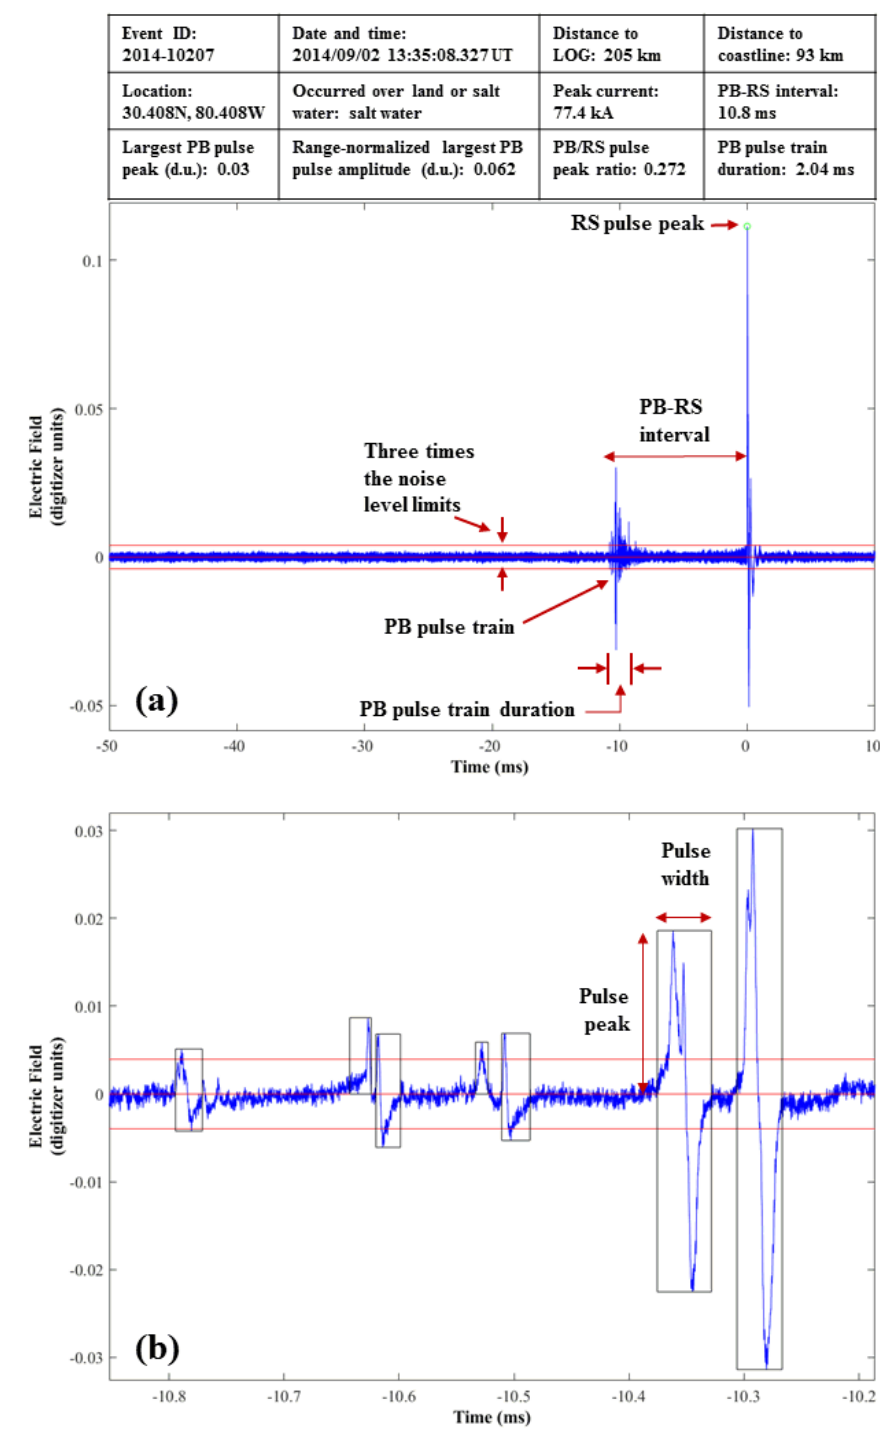
Figure 2. ( a ) An example of the output figure produced by the automated data processing algorithm, which includes a table containing pertinent information about the flash; ( b ) Expansion of the initial part of the PB pulse train shown in ( a ) with the detected PB pulses marked by boxes. The d.u. stands for digitizer units.